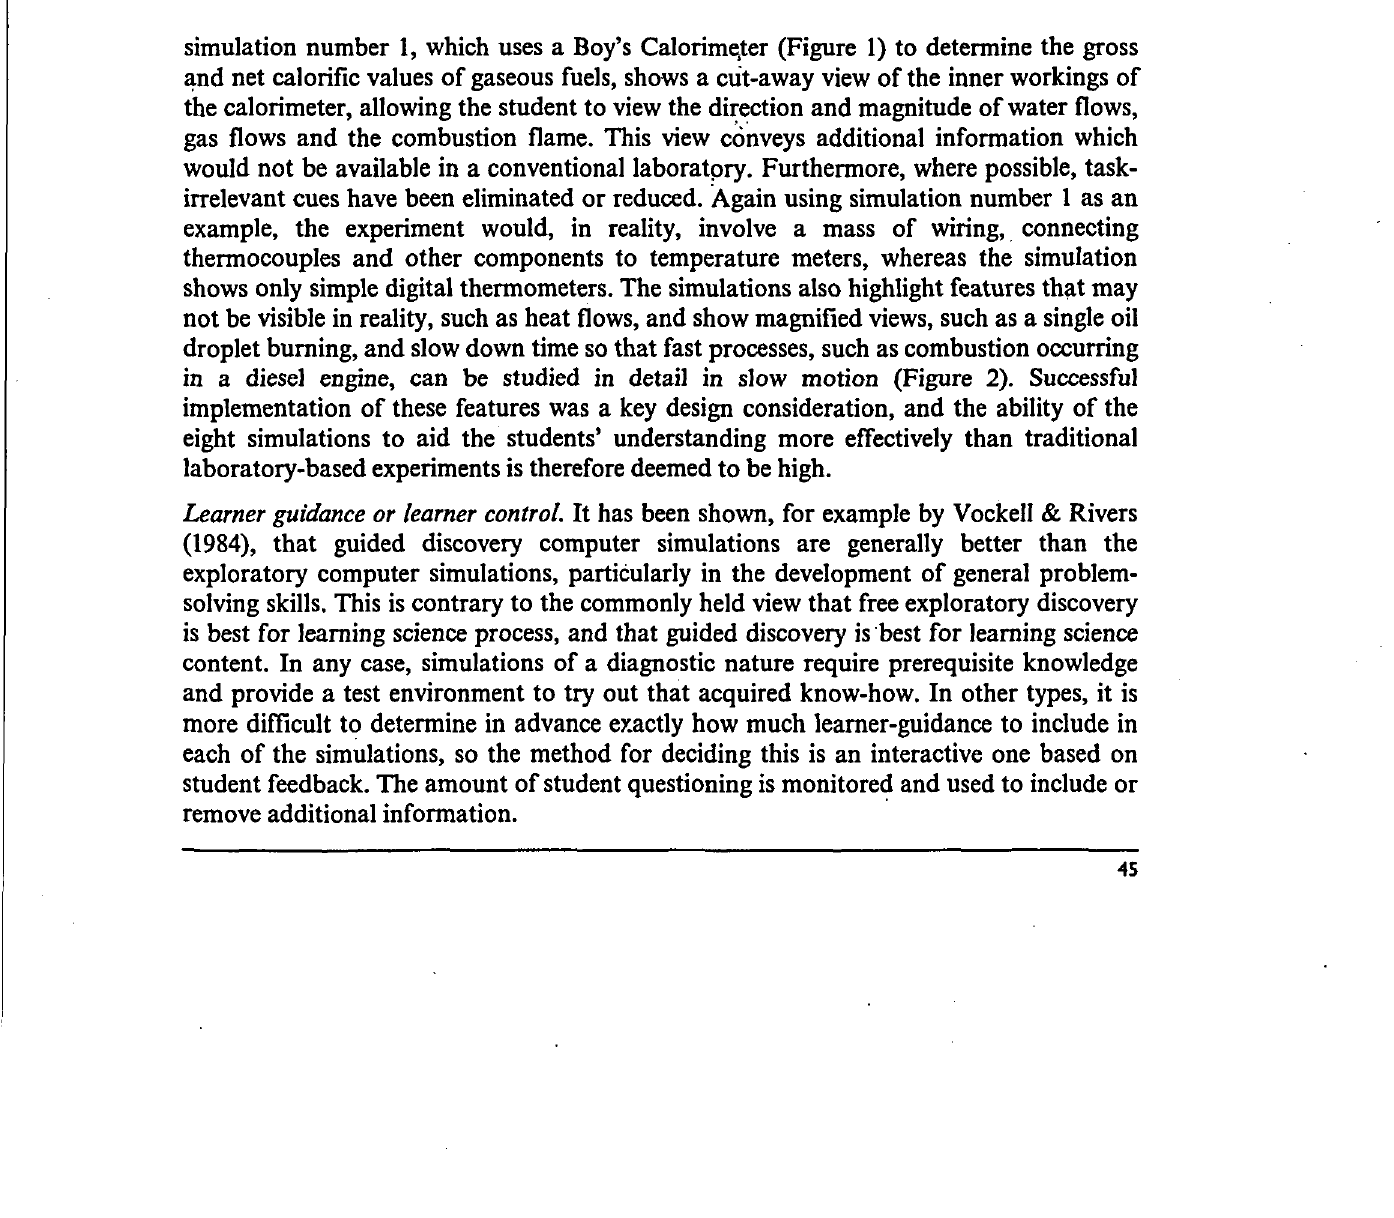
Figure I: Boy's Calorimeter